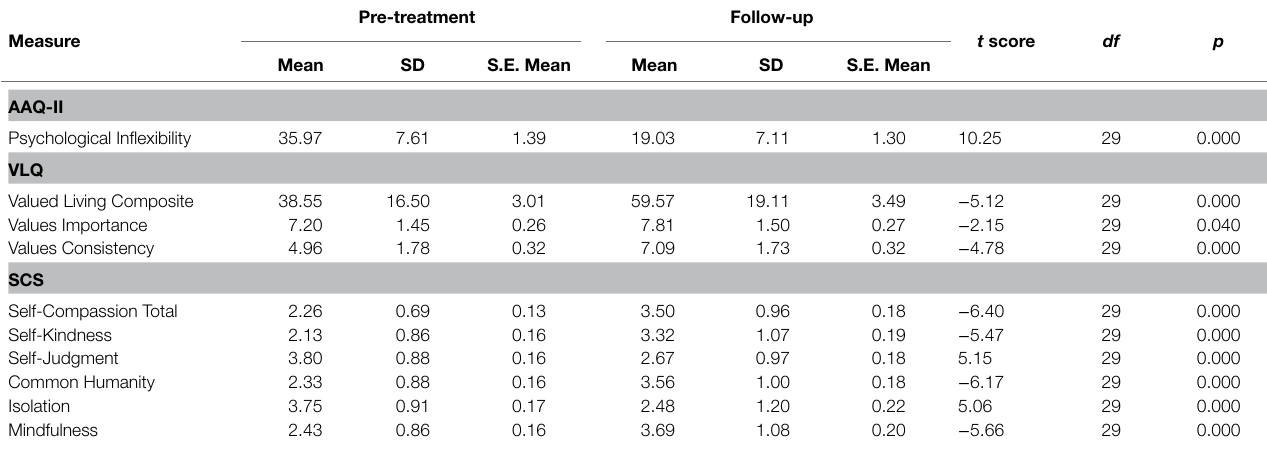
TABLE 3 | Paired sample t -test: Treatment maintenance for psychological inflexibility, values-based action, and self-compassion.